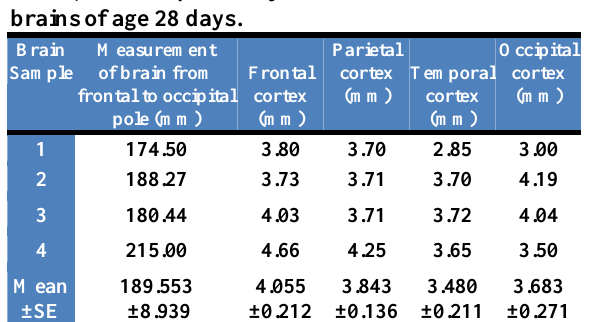
Table, 1: Morphometry (thickness) of four male brains of age 28